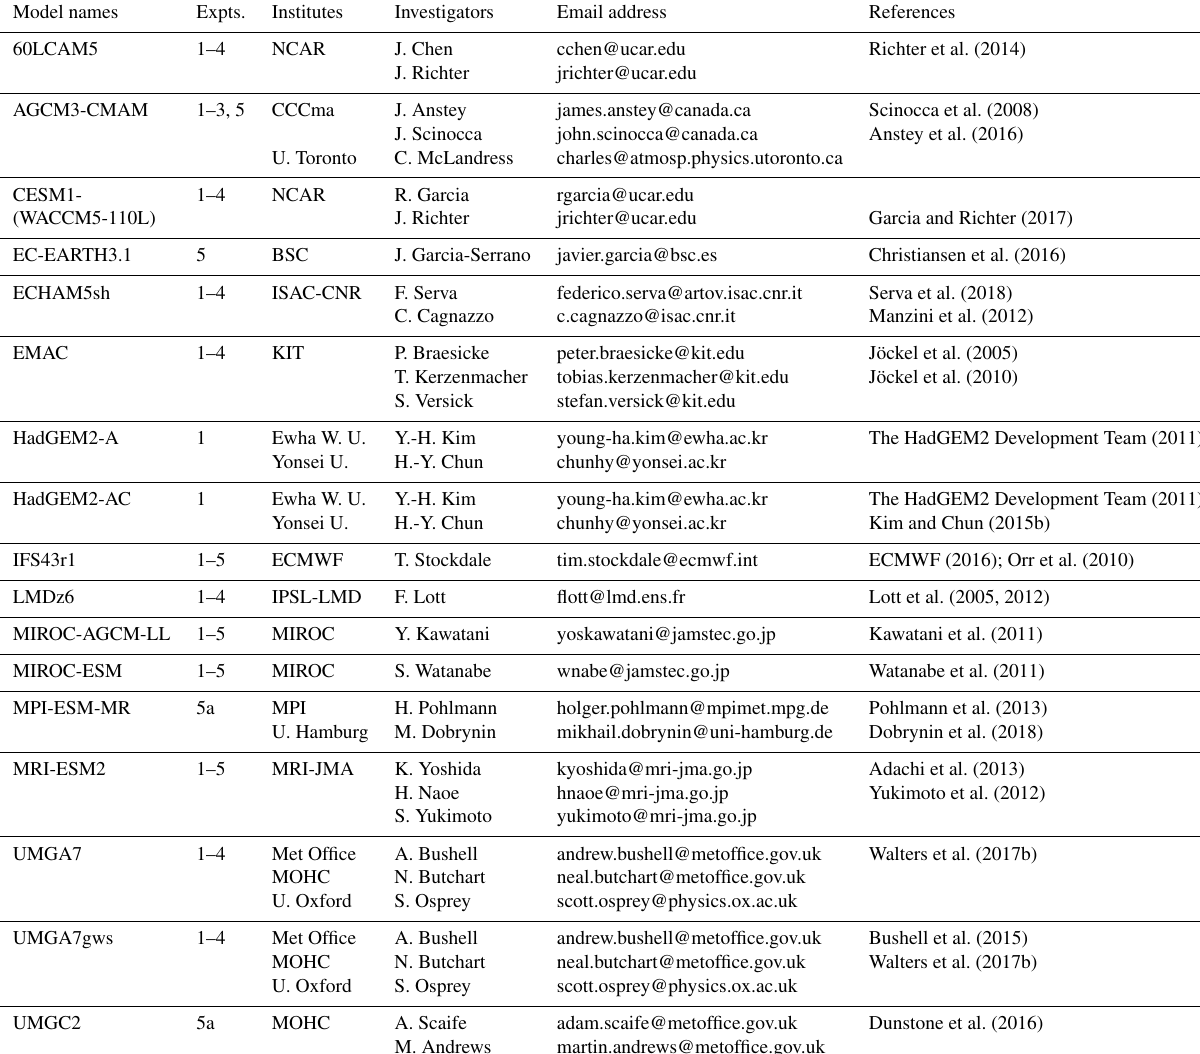
Table 5. Participating models and contact information. Model